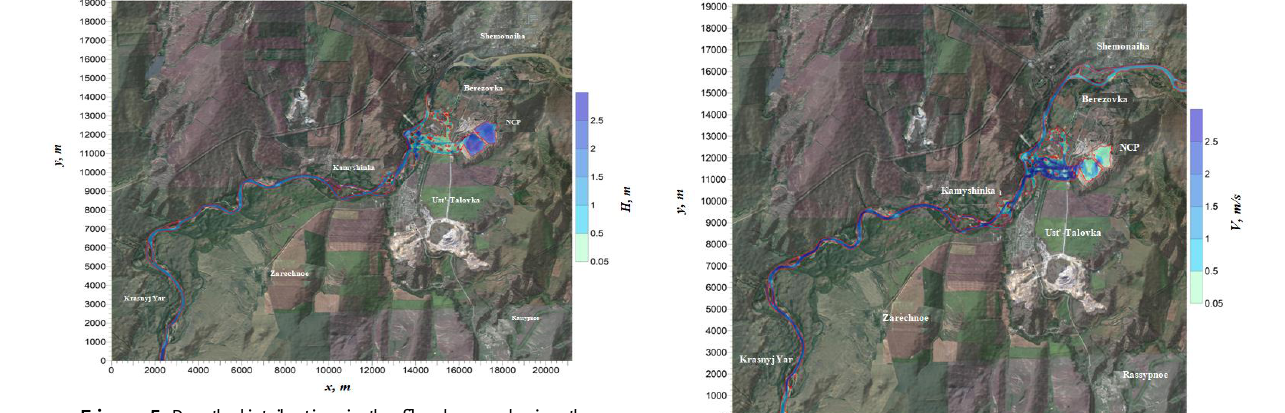
Figure 5. Depth distribution in the flood zone during the development of a hydrodynamic accident (Model 3) at the tailing dump of the processing plant.